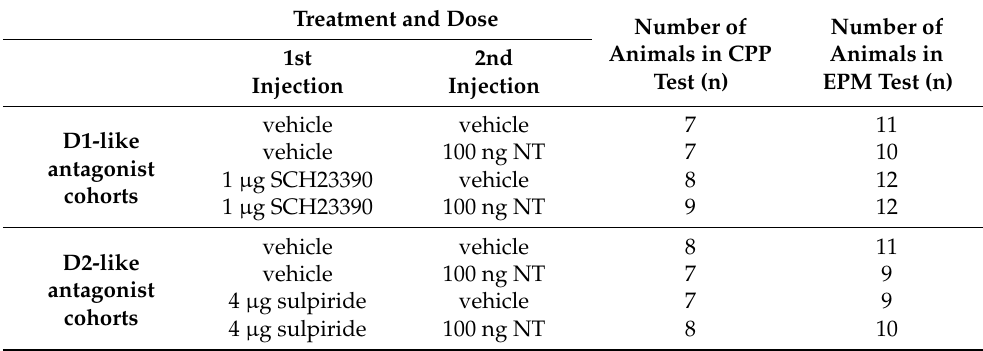
Table 1. Experimental groups and number of animals (n) in the conditioned place preference (CPP) and elevated plus maze (EPM)